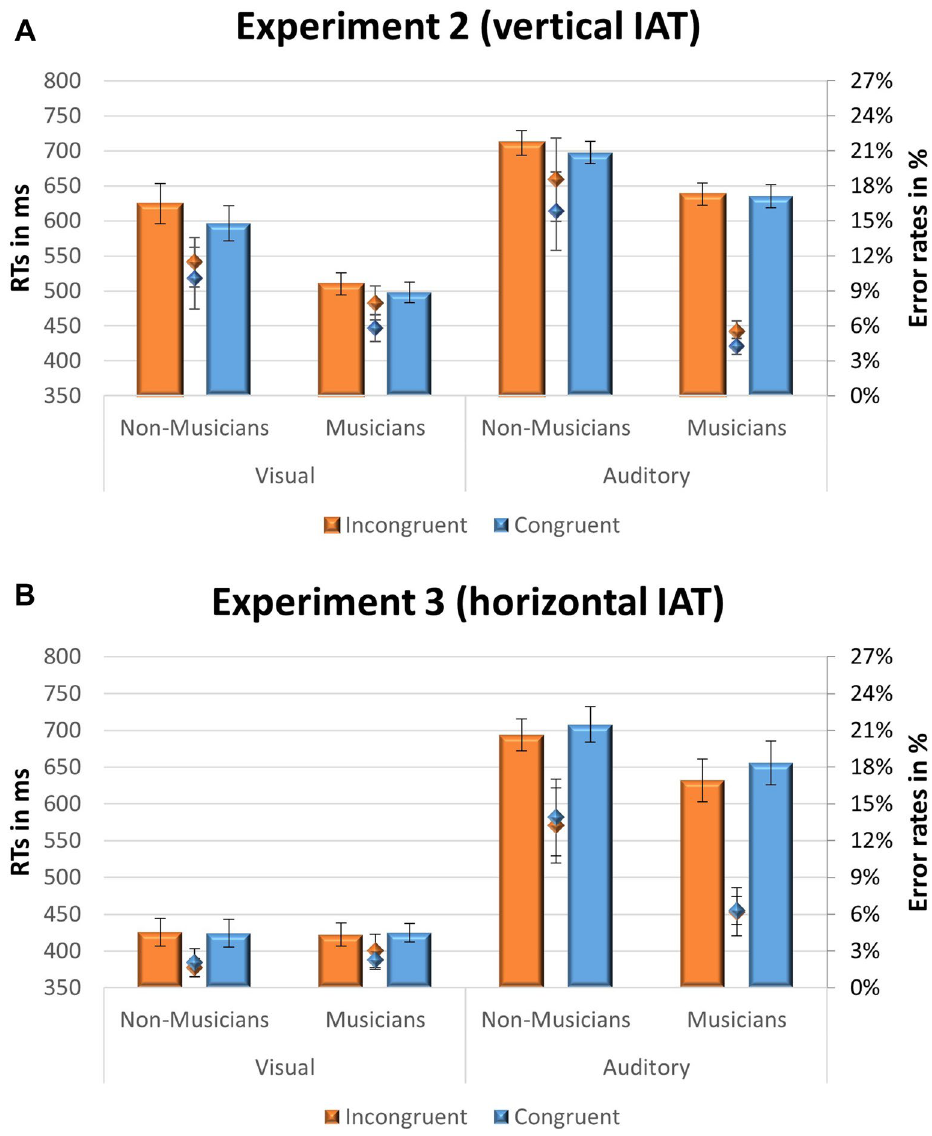
Figure 5. ( A ) Mean reaction times (bars) and error rates (diamonds) in Experiment 2 (IAT probing the vertical axis). ( B ) Mean reaction times (bars) and error rates (diamonds) in Experiment 3 (IAT probing the horizontal axis), for congruent (blue) and incongruent (red) blocks of trials, as a function of modality (visual, auditory), and musical experience (musicians, non-musicians). Congruency was determined according to Experiment 1 results (e.g., tonally stable degrees were paired with upper and left-hand positions and tonally unstable degrees were paired with lower and right-hand positions). Line bars represent the standard